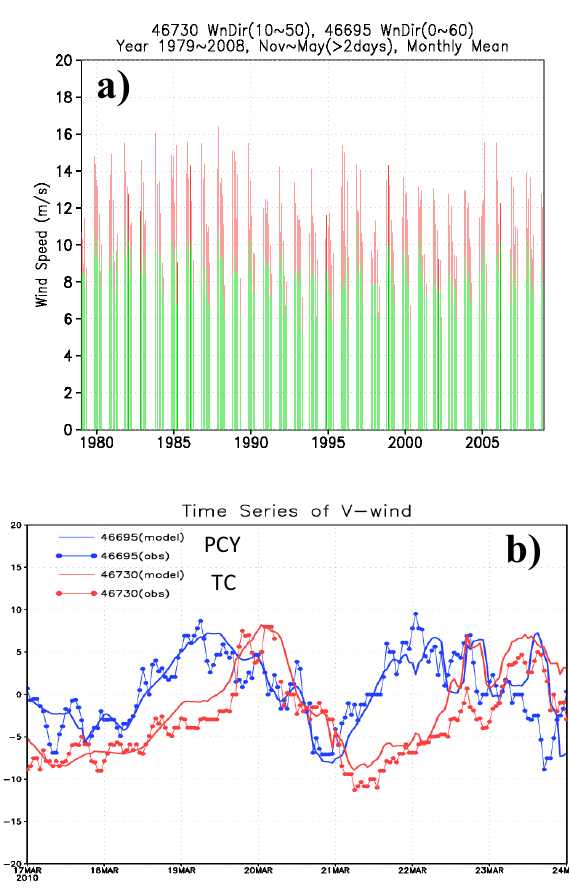
Fig. 5. (a) Time series of monthly average wind speed during north- easterly monsoon (November–May) for station TC (red bars) and station PCY (green bars) between 1979 and 2008. (b) The observa- tion and simulation N-S component of wind speed at stations PCY (blue) and TC (red) during 00:00LST, 17–24 March